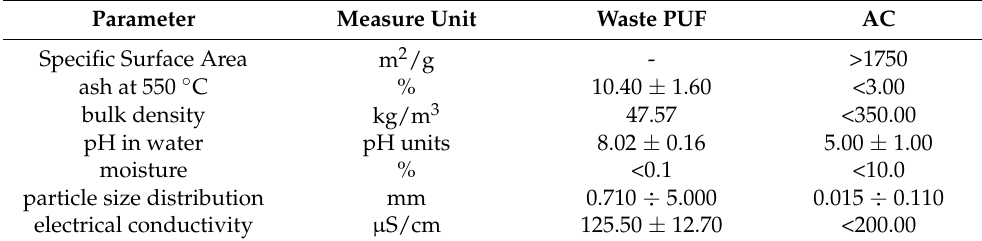
Table 2. Main features of the considered waste PUF and of the reference commercial